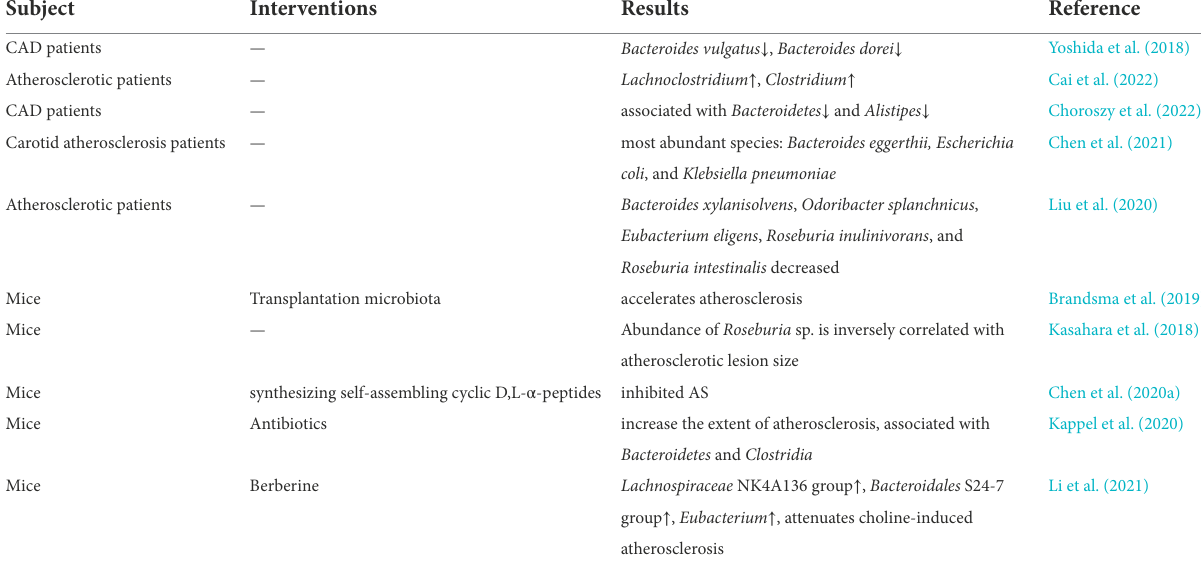
TABLE 2 Summary of the relationship between atherosclerosis and gut